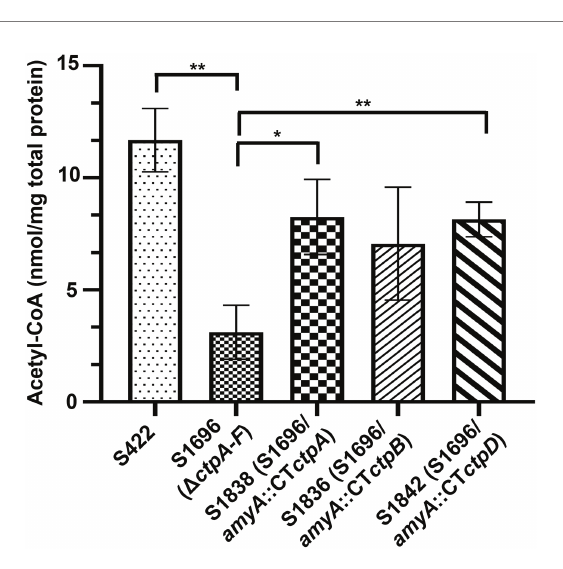
FIGURE 5 Intracellular acetyl-CoA concentrations of the indicated A. niger strains. About 1 × 10 8 conidia of each indicated A. niger strain were inoculated in 50 ml of citric acid fermentation medium at 28 ° C for 3 days, and the intracellular acetyl-CoA concentrations were determined. * p < 0.05, ** p < 0.001, and **** p < 0.0001 were considered statistically significant. This meaning are described in “Statistical analyses”